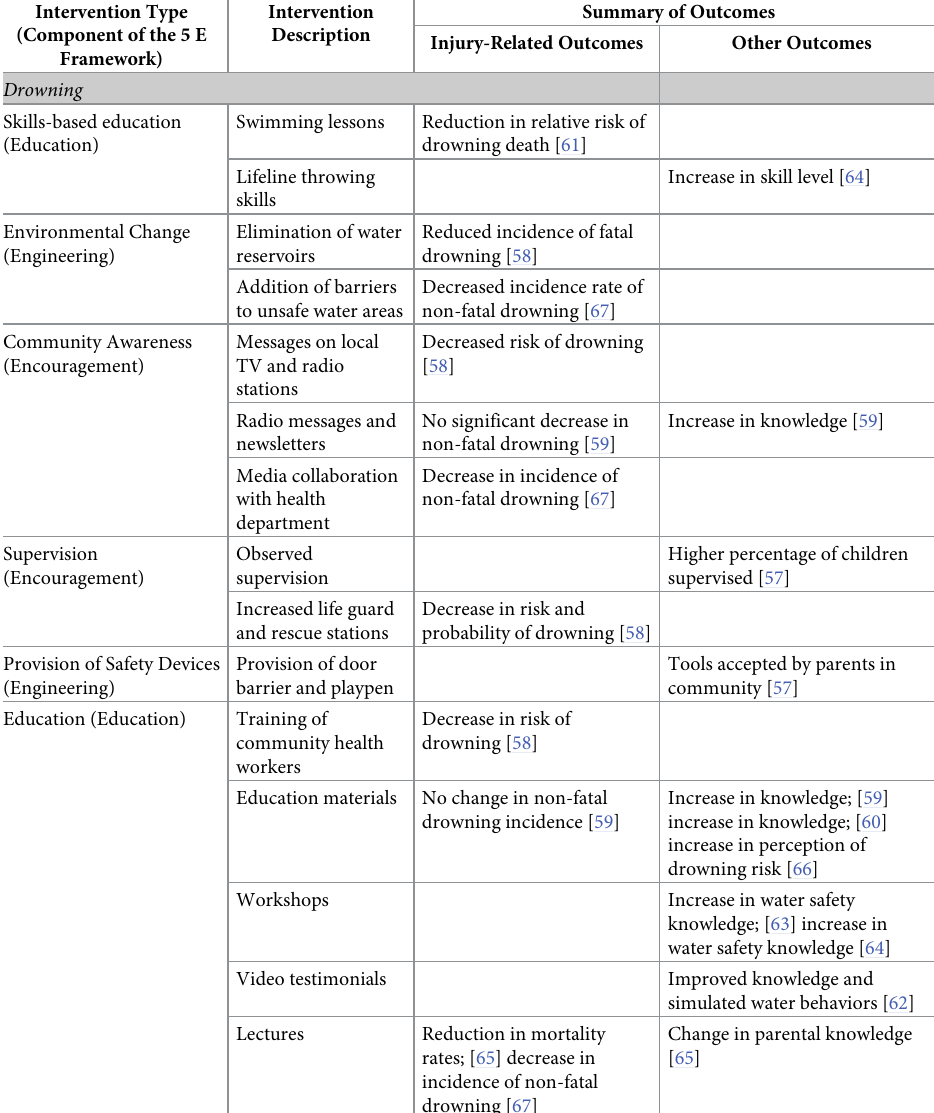
Table 3. Summary of intervention outcomes for injury types: